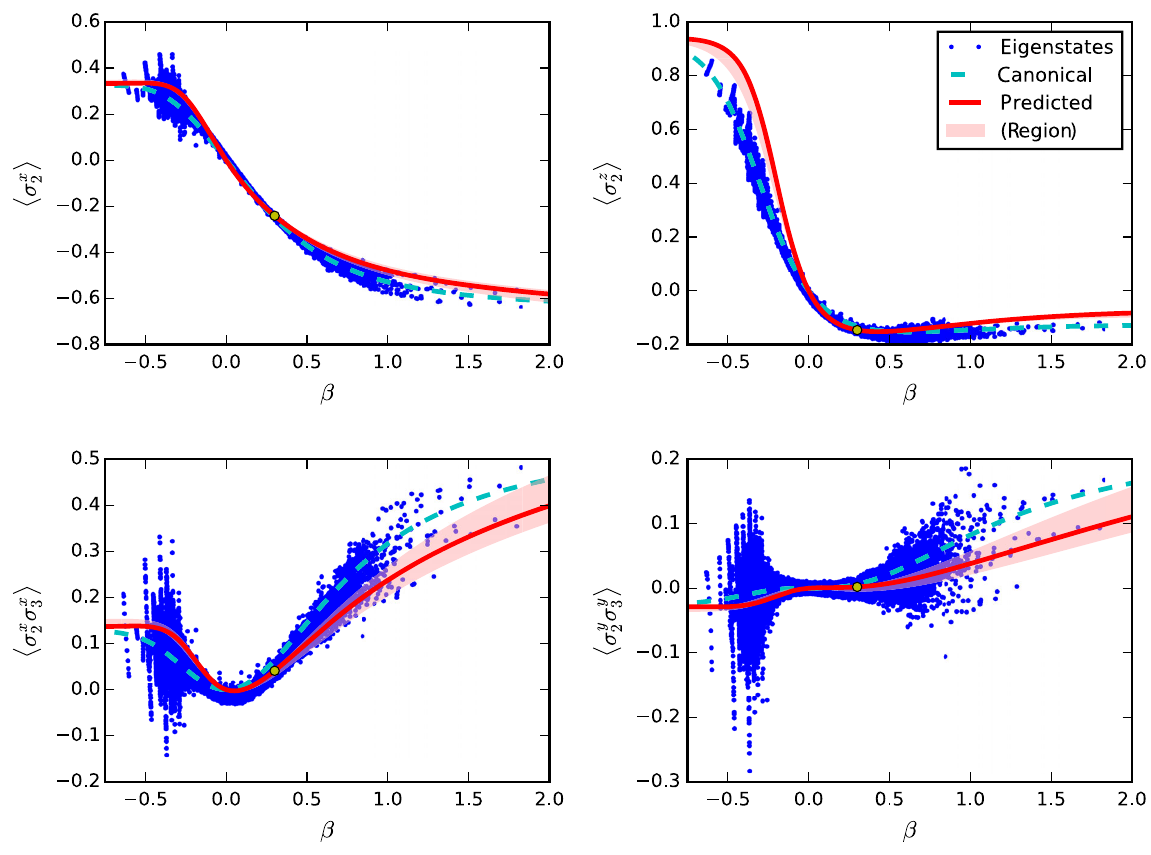
FIG. 15. Equal-time correlators for an L ¼ 21 system plotted against inverse temperature β . The blue dots denote the expectation value with respect to each eigenstate, the dashed cyan curve plots the expectation value in the canonical ensemble, and the red curve plots the expectation value predicted from a single eigenstate at β 0 ¼ 0 . 3 (yellow dot) by raising the L rescaling it to have unit trace. We also independently consider predictions from each of the 214608 eigenstates in the range 0 . 2 < β 0 . 5 : At each inverse temperature β , the pink shaded region contains predictions at most one standard deviation away from 0 < the mean prediction among all such